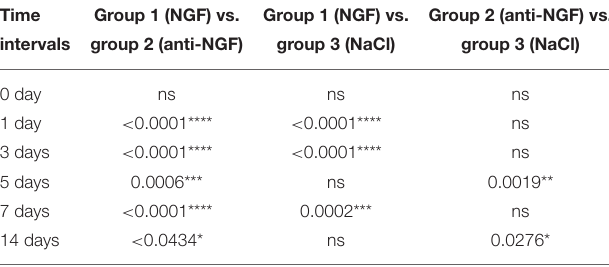
TABLE 1 | p -value of C-C chemokine ligand 19 (CCL19) mRNA expression in rats’ TGs following the injection of nerve growth factor (NGF)-related reagents.